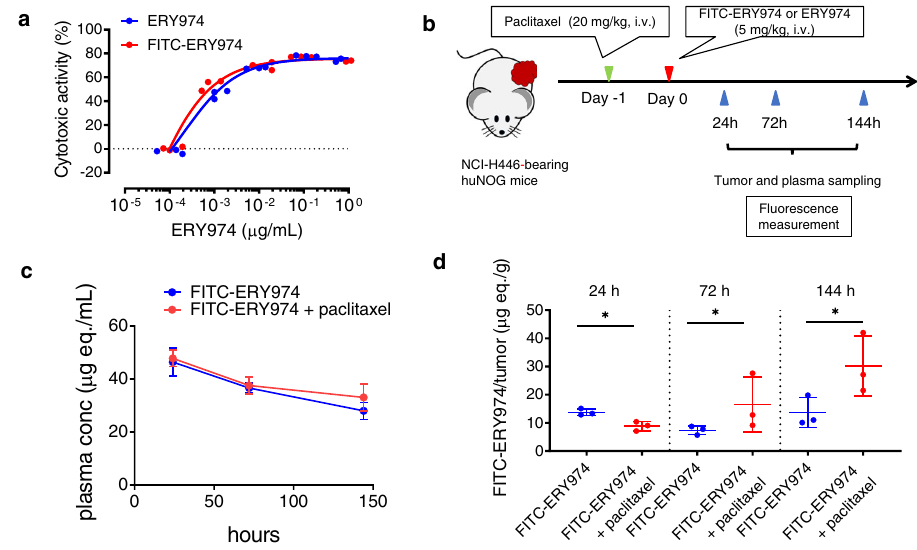
Fig. 5 | Distribution of FITC-labelled ERY974 in non-in fl amed NCI-H446 tumours is improved in combination therapy with paclitaxel. a TDCC analysis of non-labelled and FITC-labelled ERY974 in SK-pca13a cell ( n =3). b Schematic summarising the distribution study. c , d Concentration of non-labelled and FITC- labelled ERY974 in plasma ( c ) and tumours ( d ). Data were expressed as the